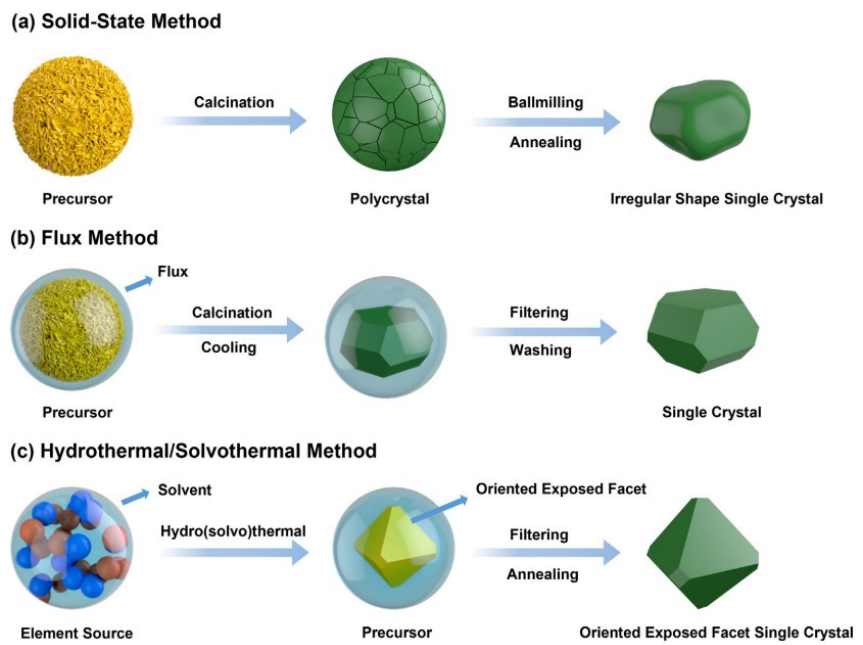
Figure 3. A schematic diagrams of the main synthesis strategies for single-crystal nickel-rich NCM materials, reproduced from Ref. [222]. Copyright 2021, Elsevier.